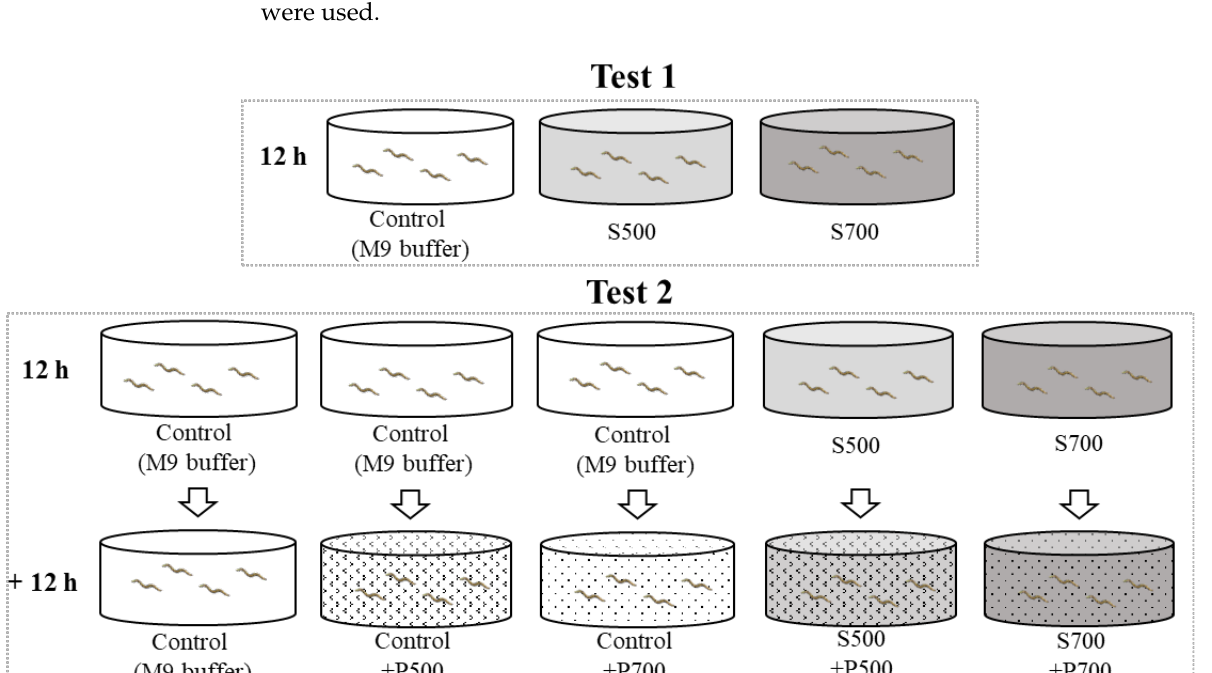
Figure 1. Diagram of the autonomic assay with supernatant (S500 and S700) and washed biochar particles (P500 and P700). Test 1: Exposure to the supernatant for 12 h. Test 2: Exposure to the supernatant for 12 h with the subsequent addition of washed particles.